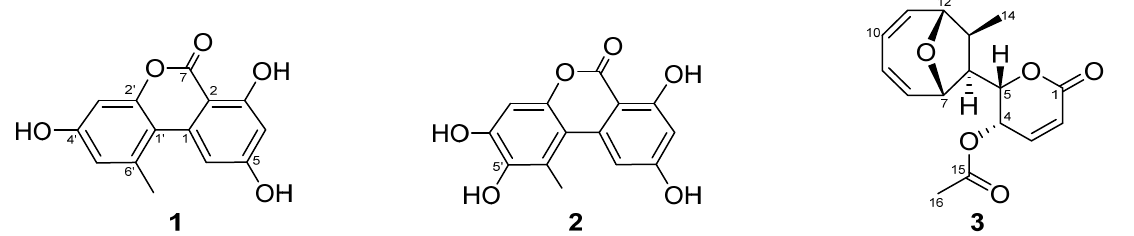
Figure 2. Chemical structures of alternariol (AT) ( 1 ), 5 ′ -hydroxy-alternariol (HAT) ( 2 ), mycoepoxydiene (MED) ( 3 ).